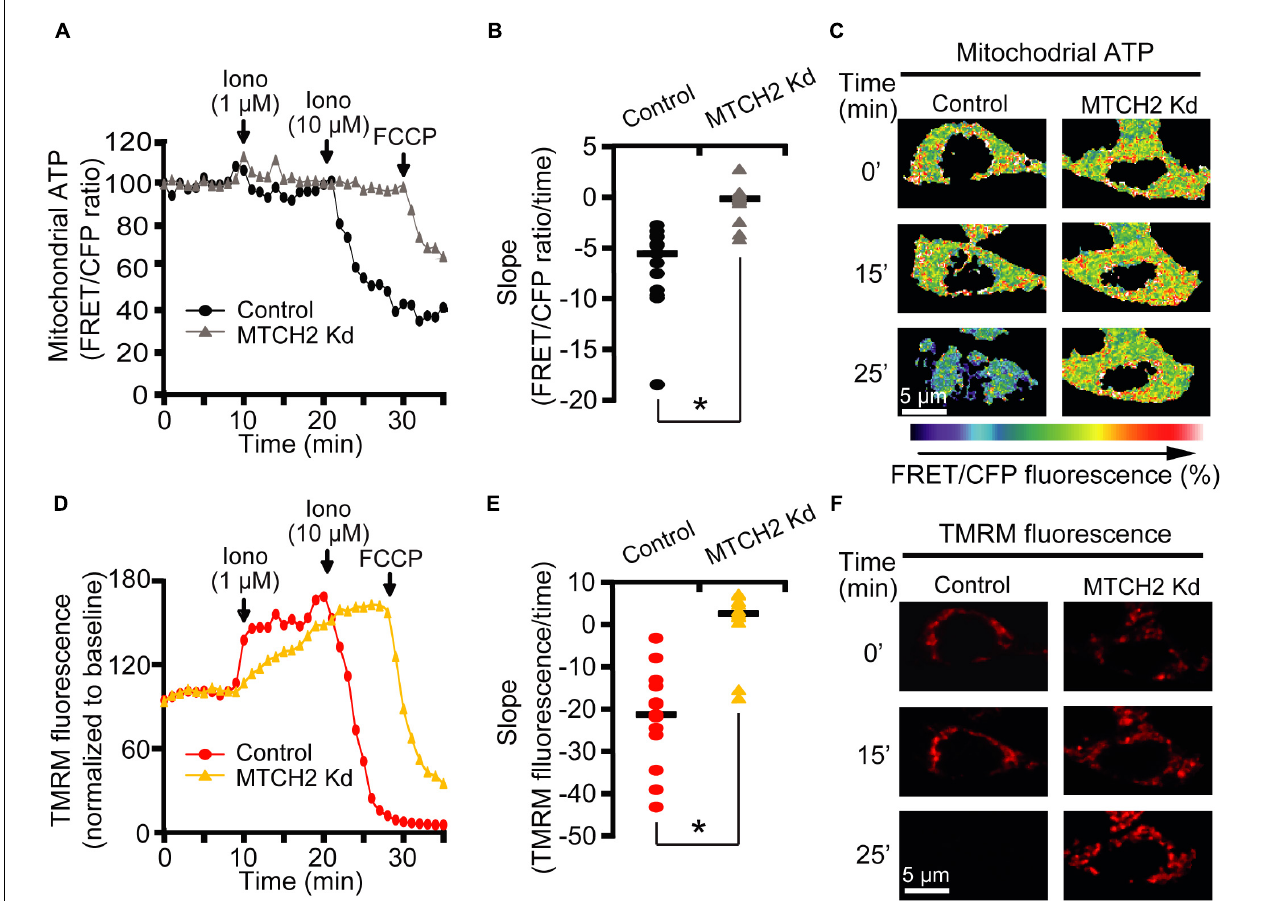
FIGURE 2 | MTCH2 influences cellular mitochondrial bioenergetics in HCT116 cells. (A–F) Bax/Bak double-deficient MTCH2 kd and control HCT116 cells were separately transfected with the mitochondria ATP-sensitive (mitoATeam) FRET probe, loaded with 30 µ M TMRM as a (cid:49) ψ m indicator (non-quenched mode), and mounted on the stage of LSM 710 confocal microscope. Fluorescent measurements were recorded for TMRM, FRET, CFP, and YFP by time-lapse confocal microscope. FRET probe imaging data are expressed as a ratio of FRET/CFP. Cell were exposed to sequential addition of 1 and 10 µ M ionomycin, and FCCP (1 µ M) at the indicated time points. Mitochondrial ATP (A) and (cid:49) ψ m (D) were analyzed after drugs addition and representative traces are shown. Quantification of the slope of mitochondrial ATP [the change in FRET/CFP ratio over time in minutes; (B) ] and (cid:49) ψ m [the change in TMRM fluorescence over time in minutes; (E) ] between 20 min time point (corresponding to the 10 µ M ionomycin treatment) and the end of experiment is illustrated. Representative images of mitoATeam-transfected (C) and TMRM-loaded (F) Bax/Bak double-deficient MTCH2 kd and control HCT116 cells before ( t = 0 min) and following the additions of ionomycin ( t = 15 min and t = 25 min, respectively) are shown. Scale bar = 5 µ M. A minimum of 15 cells from at least n = 3 independent experiments were analyzed per cell type/condition. * p ≤ 0.05 compared to Bax/Bak double-deficient control HCT116 cells (ANOVA, post hoc